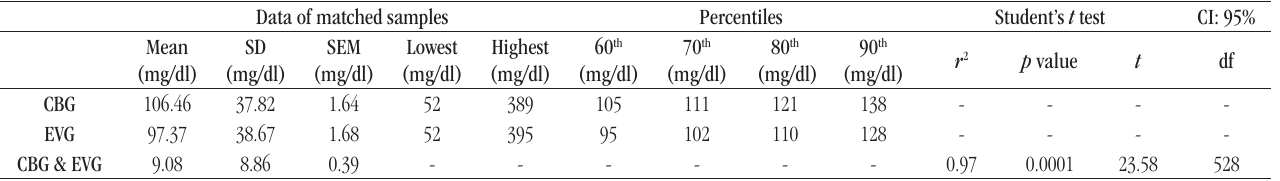
table – Analysis of correlation between matched samples of capillary and serum glucose Data of matched samples